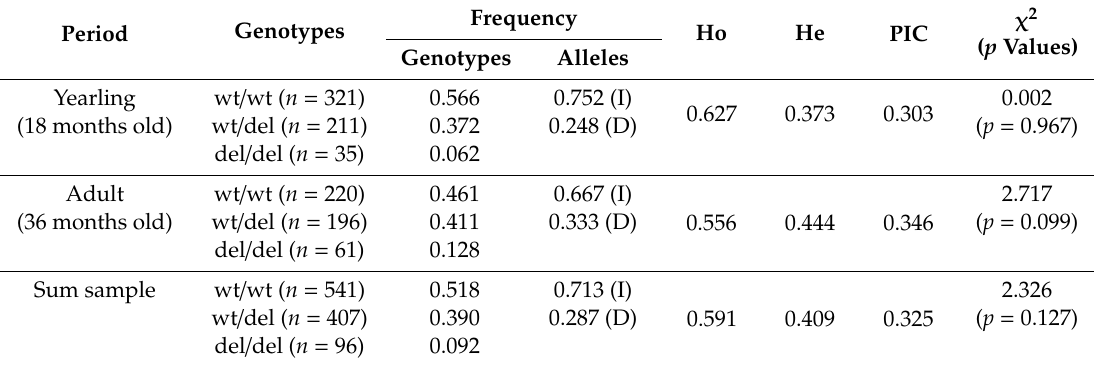
Table 3. Sequence variation frequencies and population indexes for the mutation in Shaanbei white cashmere